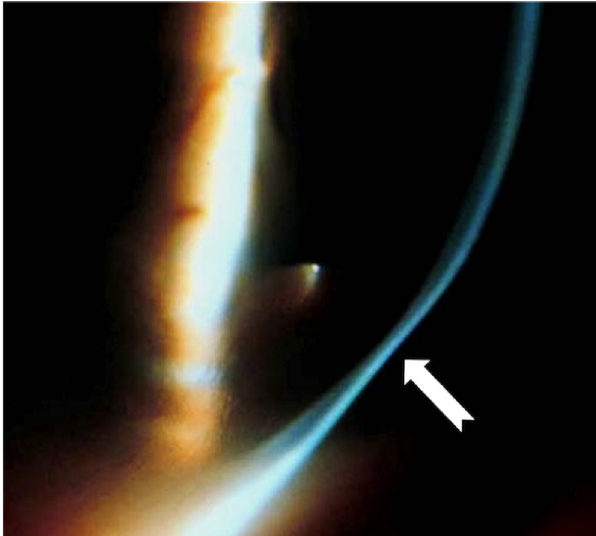
Figure 3. Inferior corneal thinning on Slitlamp biomicroscopy in PMD. Notice the abrupt narrowing of the slit beam in the area of inferior thinning (white arrow).